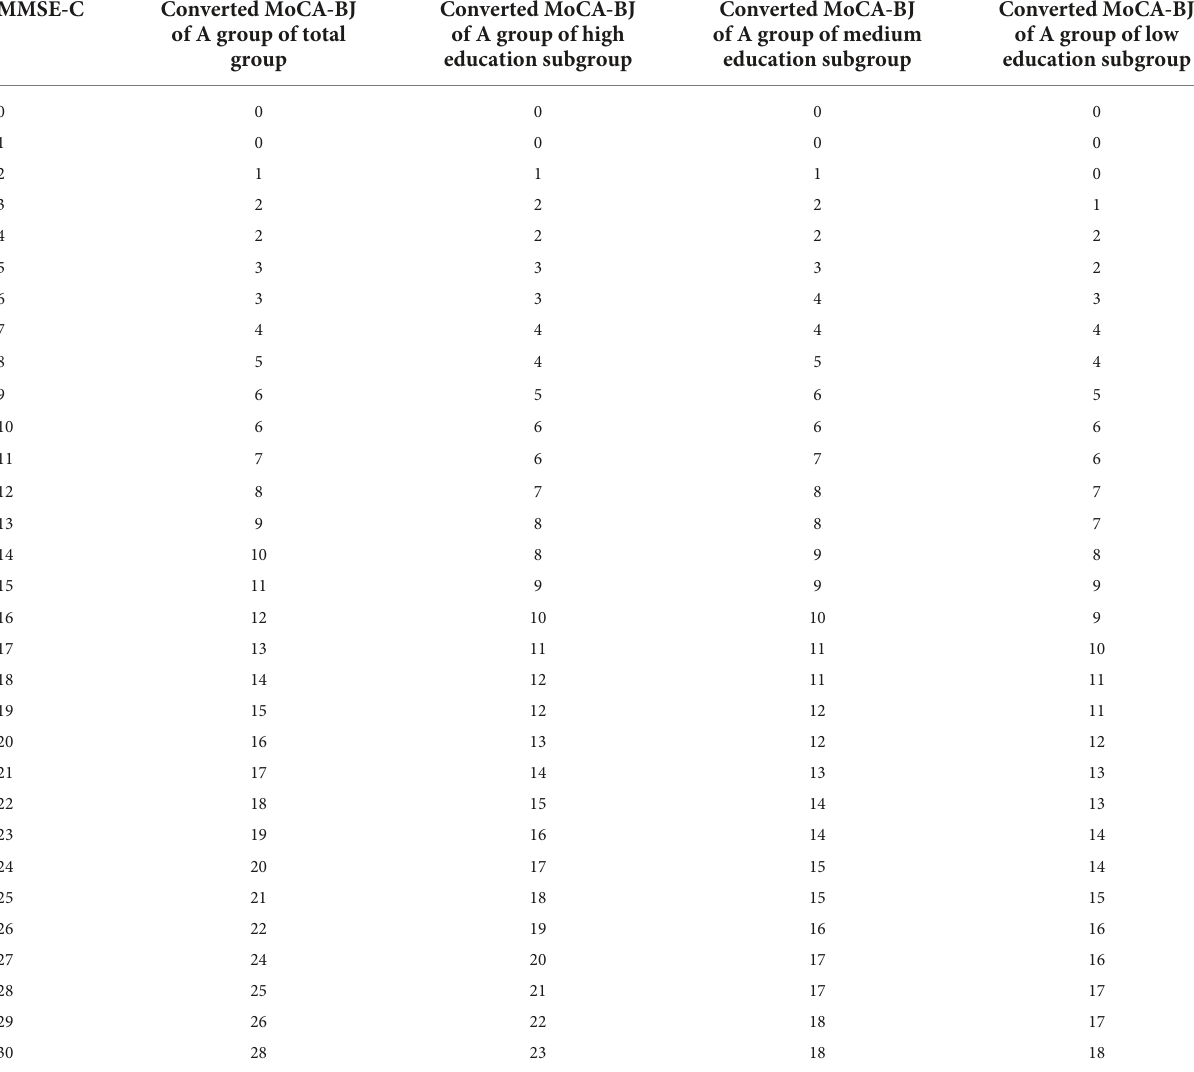
TABLE 3 Mini-mental state examination (MMSE-C) and converted montreal cognitive assessment (MoCA-BJ) of